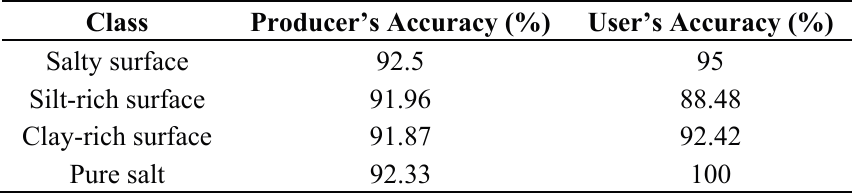
Table 4. Accuracy assessment of